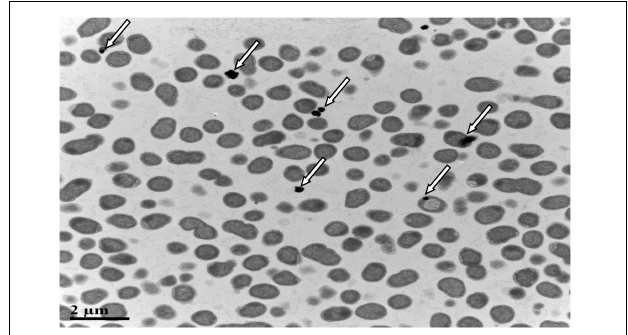
FIGURE 7 | Transmission electron microscopy (TEM) micrographs showing SeNPs produced by Proteus mirabilis QZB-2 after 24 h of incubation with 2 mM sodium